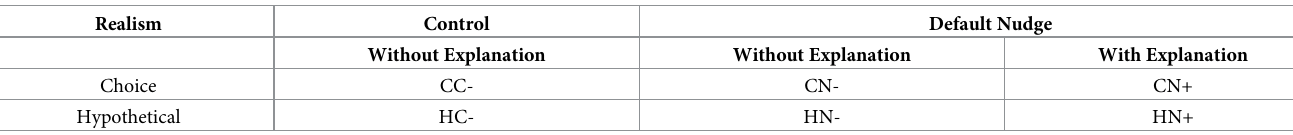
Table 1. Conditions in Study